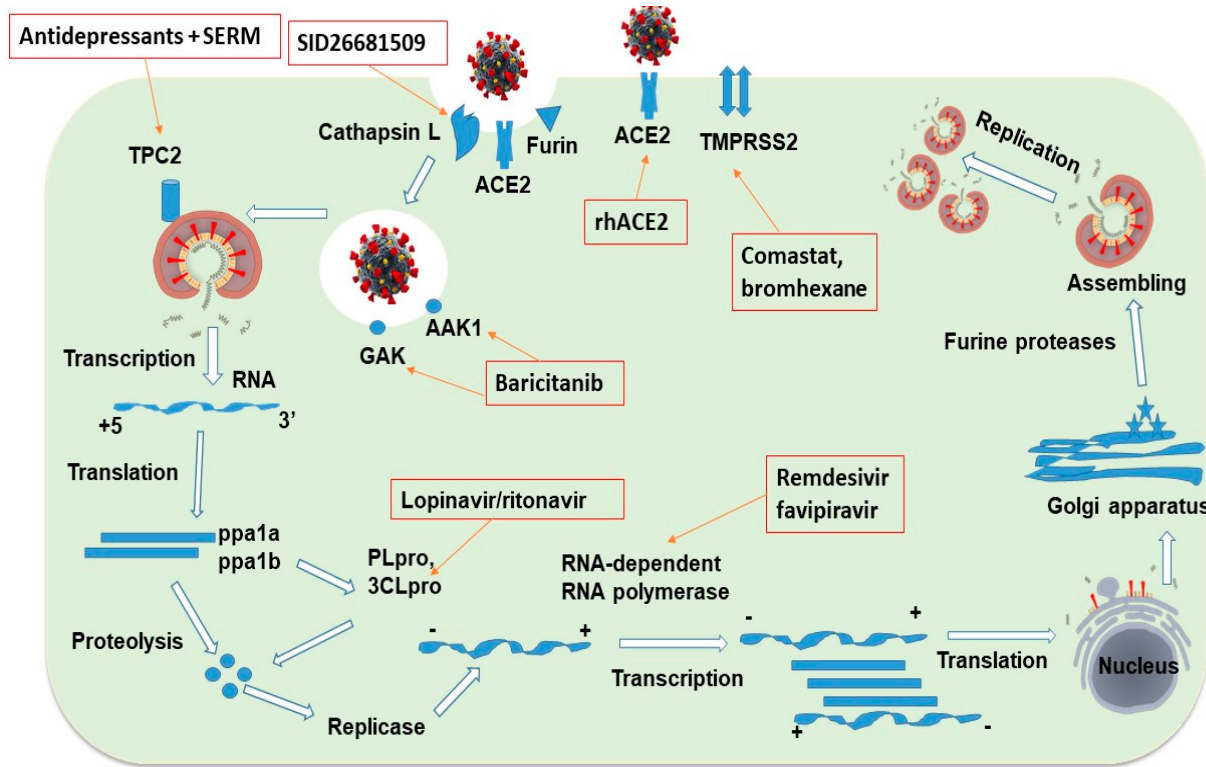
Figure 1. Schematic presentation and druggable target of SARS-CoV-2 (the figure is drawn by the author using Microsoft PowerPoint).